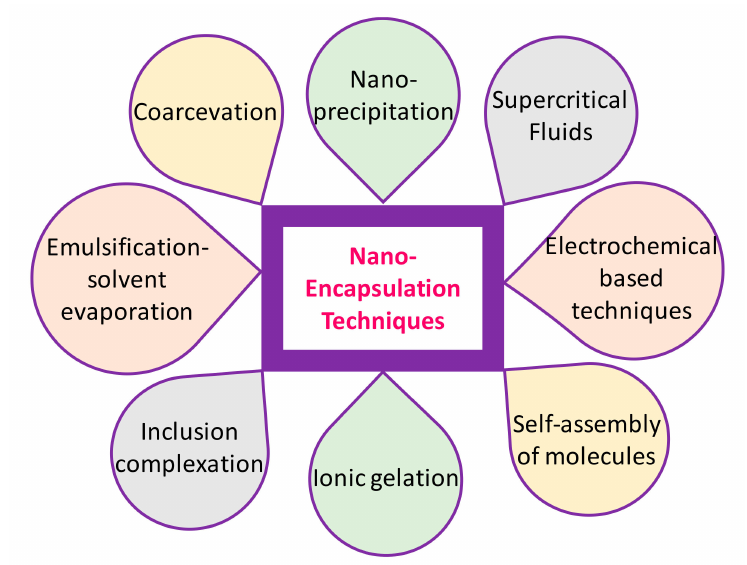
Figure 2. Techniques for nanoencapsulation of food